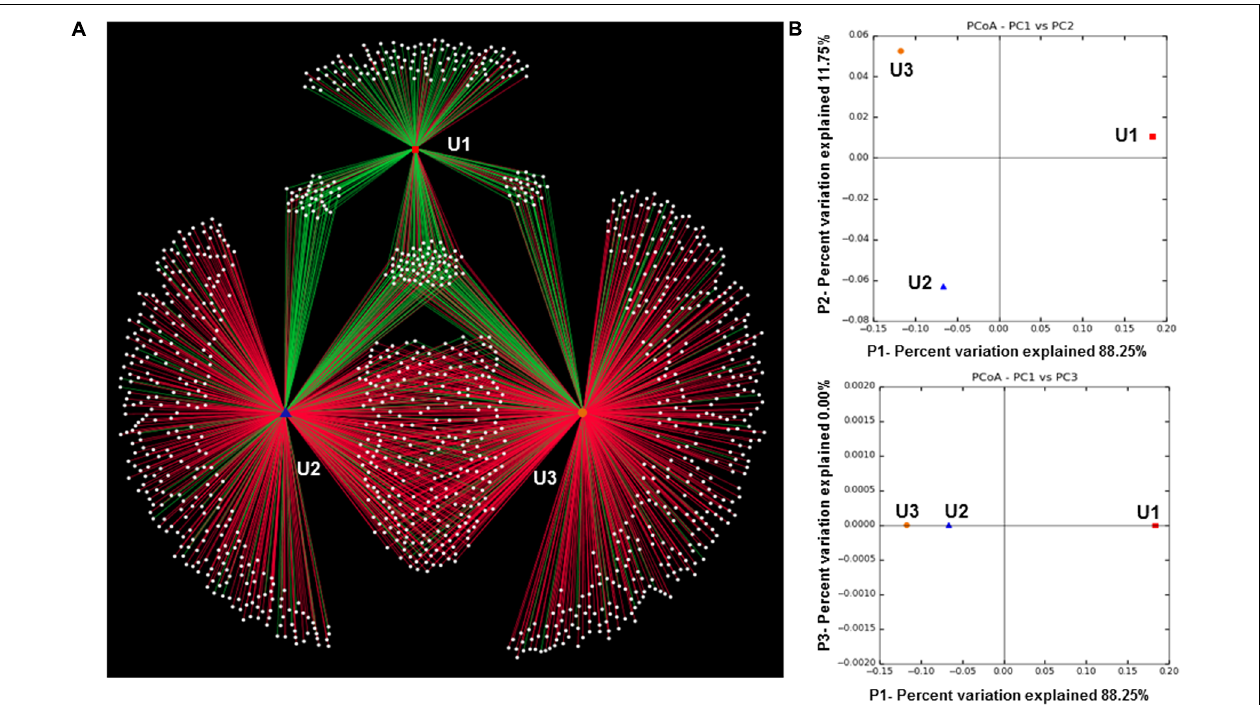
FIGURE 5 | (A) Operational Taxonomic Units (OTU) network generated through QIIME (v1.8.0) and Cytoscape (v2.8.2). The green and red edges from the peripheral white nodes are OTUs representing cyanobacteria and heterotrophic bacteria, respectively. The Edge-Weighted Spring-Embedded Eweights format was used to generate the OTU network map; (B) two PCoA plots generated by QIIME (v1.8.0) representing significant differences in bacterial community cluster among U1, U2, and U3 of the conical microbial mat from Lake Untersee,